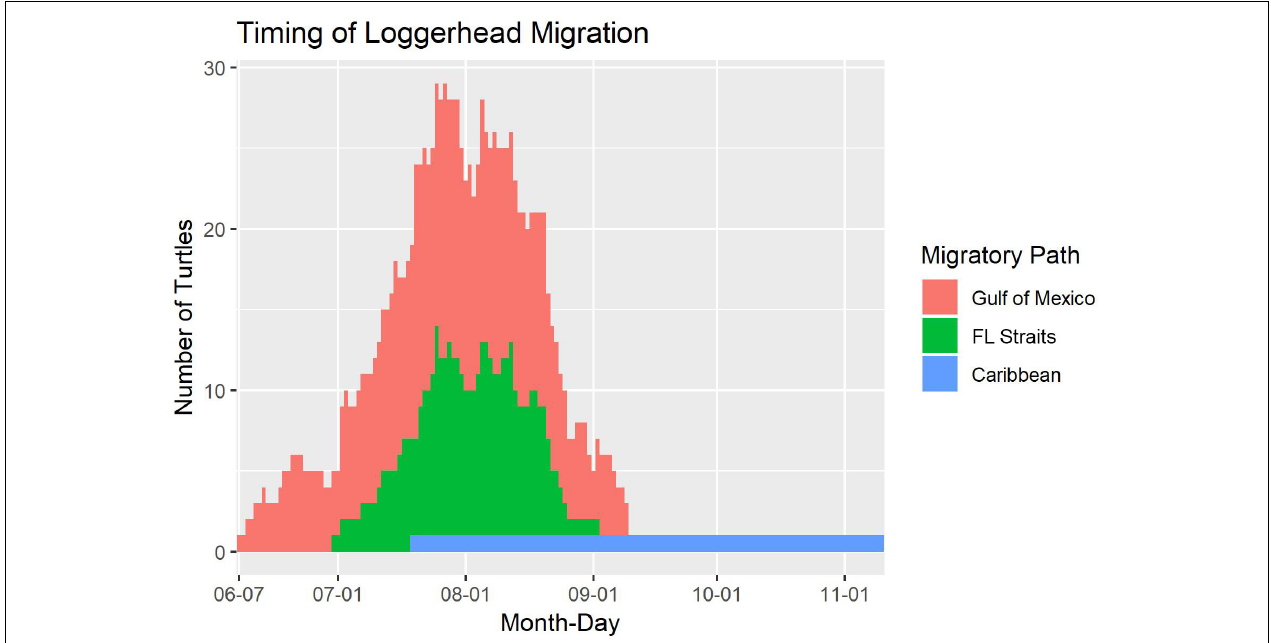
FIGURE 3 | The timing of migration paths taken by 81 adult female loggerhead sea turtles ( Caretta caretta ; 89 tracks) after being tagged at nesting beaches throughout the Gulf of Mexico. The migrations are split by which area the turtle traveled through on migration: the Gulf of Mexico, the Florida (FL) Straits, or the Caribbean. The long tail after September 6 is from the turtle that traveled to